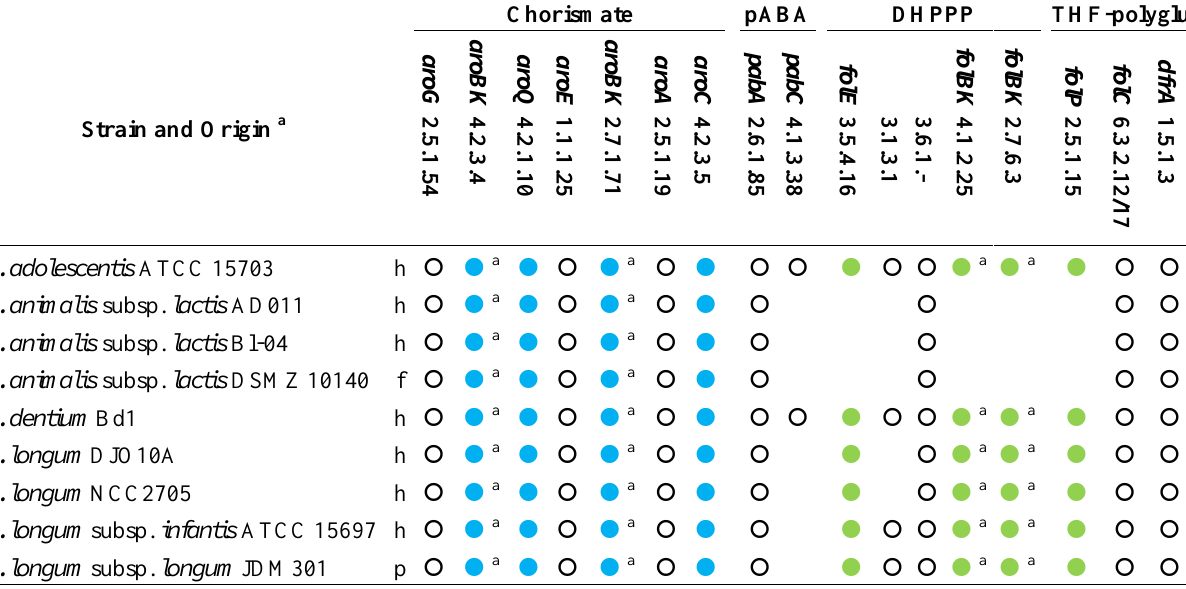
Table 2. Genes and enzymes for the biosynthesis of DHPPP, THF-polyglutamate, chorismate, and pABA predicted from the sequenced genomes of genus Bifidobacterium [46]. Abbreviations: pABA, para-aminobenzoic acid;